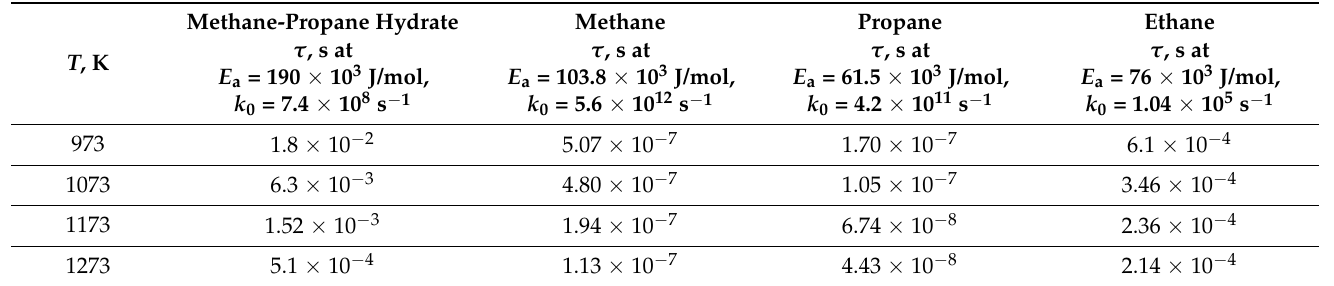
Table 2. The ignition delay times of the methane-propane gas hydrate, methane, propane, and ethane. Methane-Propane T , K